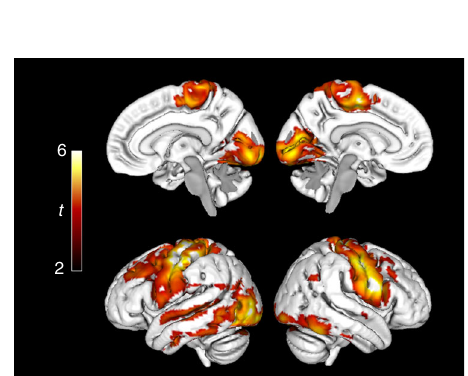
Fig. 3 Late A β accumulation regions in ADNI. Voxelwise comparisons of annual SUVR change in early A β accumulators (CSF+/PET − , n = 59) and late A β accumulators (CSF+/PET+, n = 191). A signi fi cantly increased SUVR rate is seen in the sensorimotor cortex, occipital lobe, and dorsal temporal lobe in late compared with early A β accumulators. Voxelwise two-sample t - tests were used and all comparisons were adjusted for age and gender. The signi fi cance threshold was set at p < 0.001. The red and yellow colors illustrate signi fi cant t values according to the scale on the